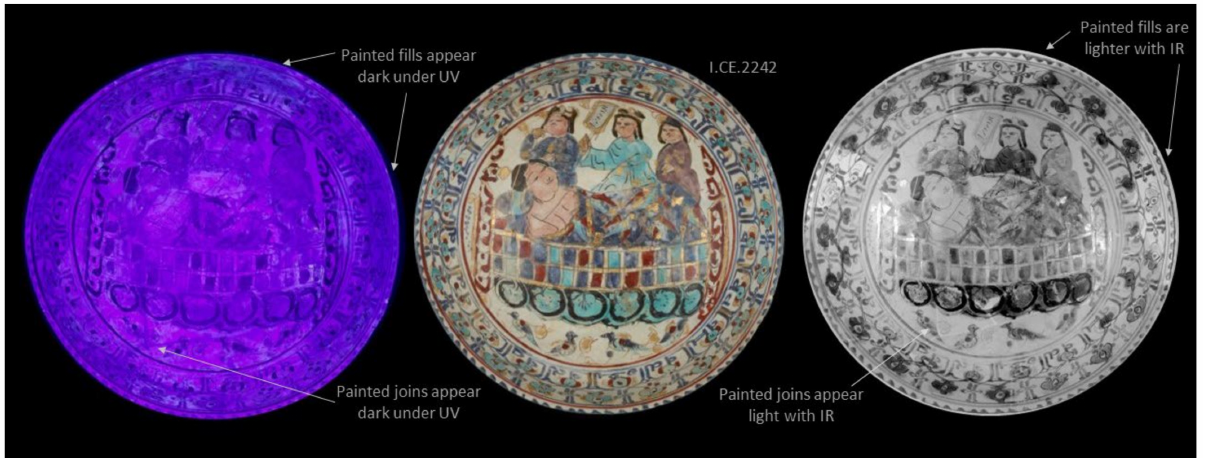
Figure 3. Results of digital photography under ultraviolet light (UV) left, standard visible light centre, and infrared reflectography (IR) on the right for I.CE.